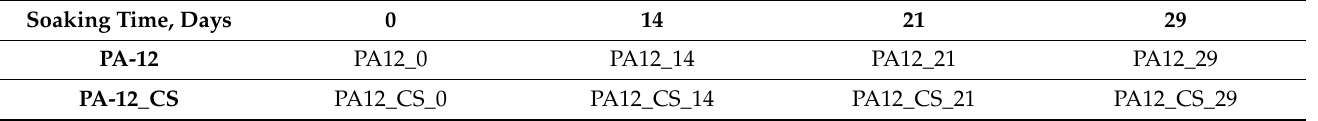
Table 3. Descriptions of the samples used for soaking and mechanical